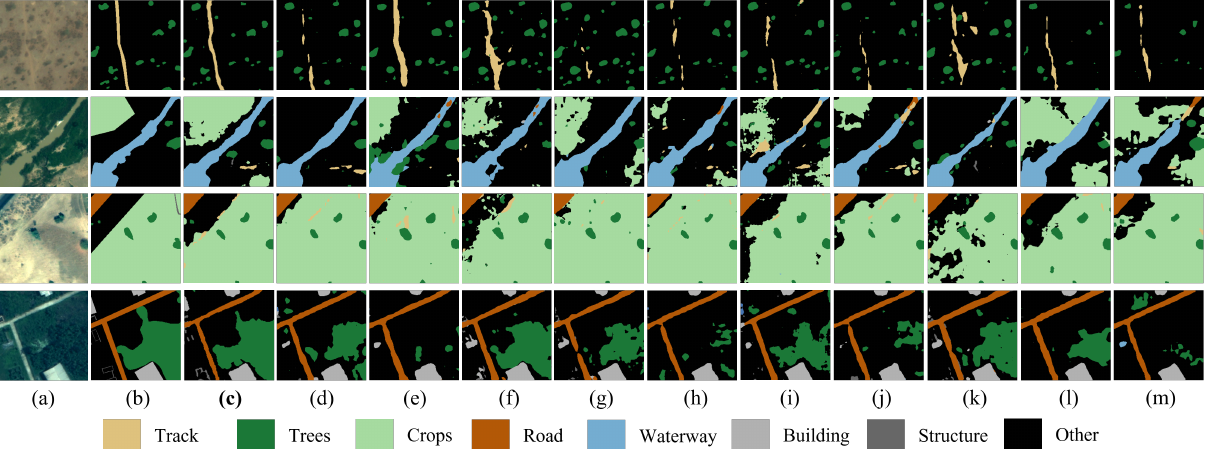
Figure 8. Comparison of different state-of-the-art models segmentation results on the DSTL dataset: ( a ) Raw image, ( b ) Ground truth, ( c ) DEANet(Ours) , ( d ) GCNet, ( e ) PSPNet, ( f ) UNet, ( g ) DeepLabv3, ( h ) DeepLabV3+, ( i ) EncNet, ( j ) PSANet, ( k ) DeepLabV3+ *, ( l ) DeepLabV3 *, ( m ) EncNet *. (* represents using a 101-layer